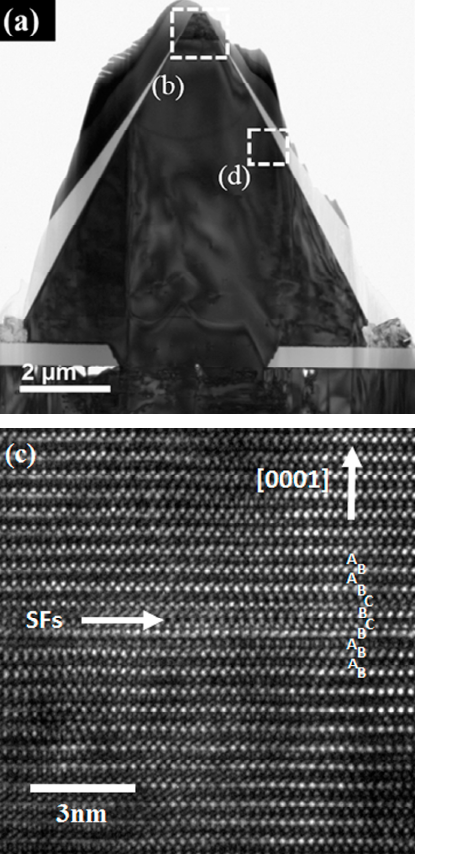
Figure 4. ( a ) Bright-field TEM image of the cross-section of a whole ridge. Enlarged high-resolution TEM (HR-TEM) image of ( b ) the wire part with ( c ) an enlarged image for a stacking fault (SF) and ( d ) the film part.